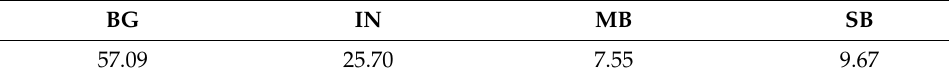
Table 1. Proportion of numbers of pixels in different classes (%).